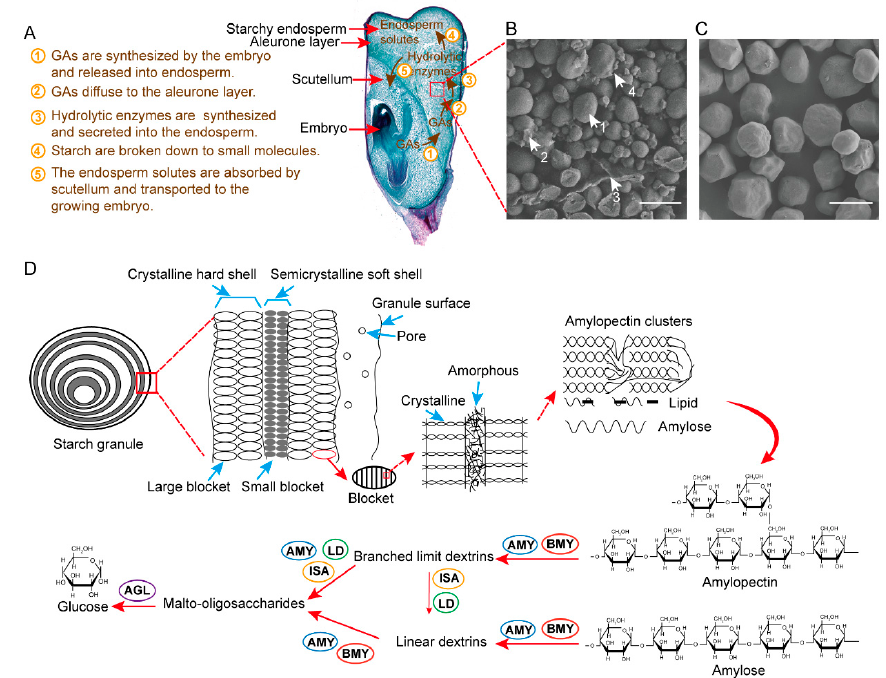
Figure 2. Starch granules in maize kernel and starch degradation during seed germination. The key enzymes involved in starch degradation in vivo were indicated. ( A ) Starch degradation represented within a seed. GA, gibberellic acid. ( B ) Scanning electron microscopy of starch granules in maize endosperm [68]. Bar = 20 μ m. 1, starch granule; 2, protein body; 3, cell wall; 4, amorphous debris. ( C ) Scanning electron microscopy of isolated starch granules [68]. Bar = 20 μ m. ( D ) Starch degradation pathway in vivo. AMY, α -amylase; BMY, β -amylase; ISA, isoamylase; LD, limit dextrinase; AGL, α -glucosidase.